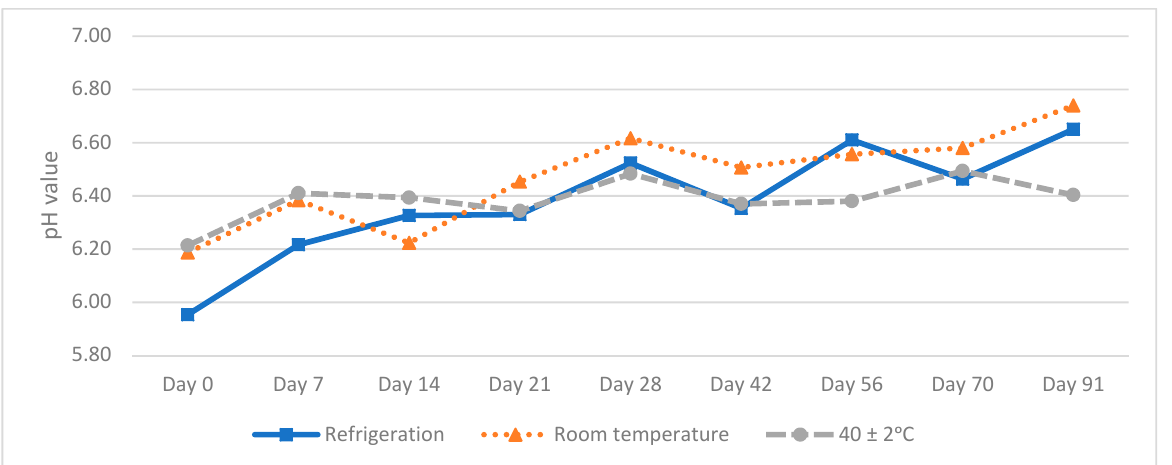
Figure 4. pH values of methadone hydrochloride (10 mg/mL) with the preservative (M2) oral solu- tion.